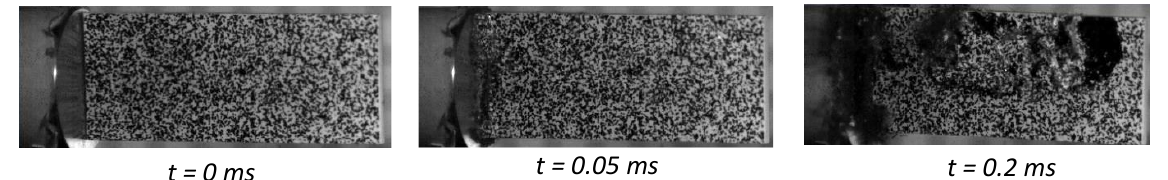
Fig. 8. Impact experiment of CFRP launched at